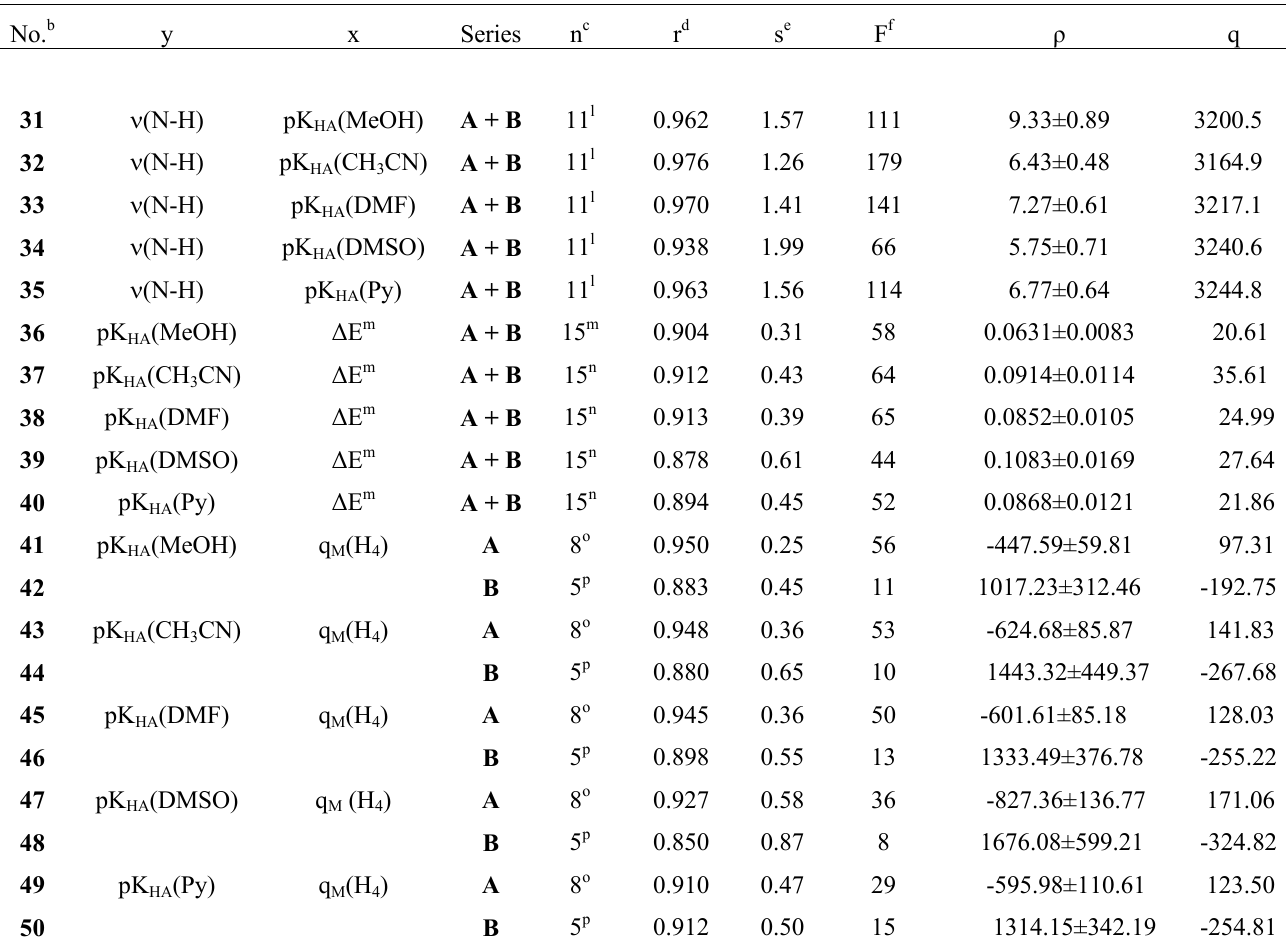
a Measured in CHCl . b Ordinal number of the correlation. c Number of compounds used in 3 correlation. d Correlation coefficient. e Standard deviation. f Fisher-Snedecor test for parameters significant at the 95 % level. g Compound 6 omitted. h Compounds 1 and 2 omitted. i Compound 11 omitted. j Compounds 1, 2, 9, 10 and 11 omitted. k Compound 16 omitted. l Compounds 1, 2, 6, 9 and 10 omitted. m See Eq(1). n Compound 10 omitted. o Compounds 8, 10 omitted. p Compounds 5, 13